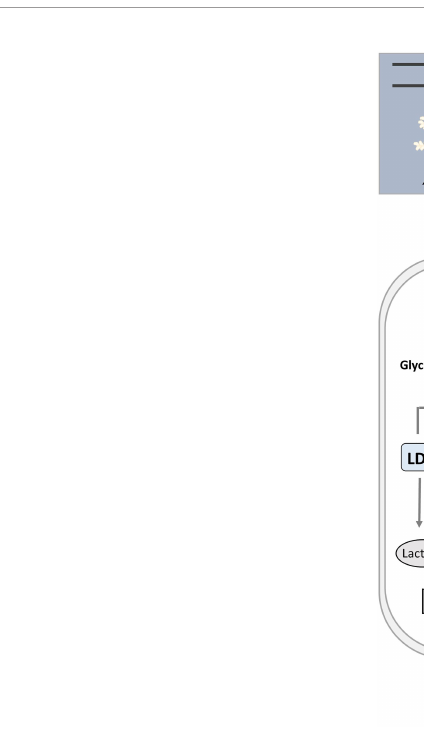
FIGURE 4 | Hypoxia stress gene set expansion may coincide with increased coral stress tolerance and bleaching resilience. Schematic illustration of hypoxia-stress associated genes with > 2 independent expansions: melatonin receptors ( MTNR ), universal stress protein ( USP ), octopine dehydrogenase ( ODH ), and carbonic anhydrase 9 ( CA9 ). Genes represented by a thick blue frame were found expanded in Porites lutea , a species ascribed as more stress tolerant, in contrast to Acropora